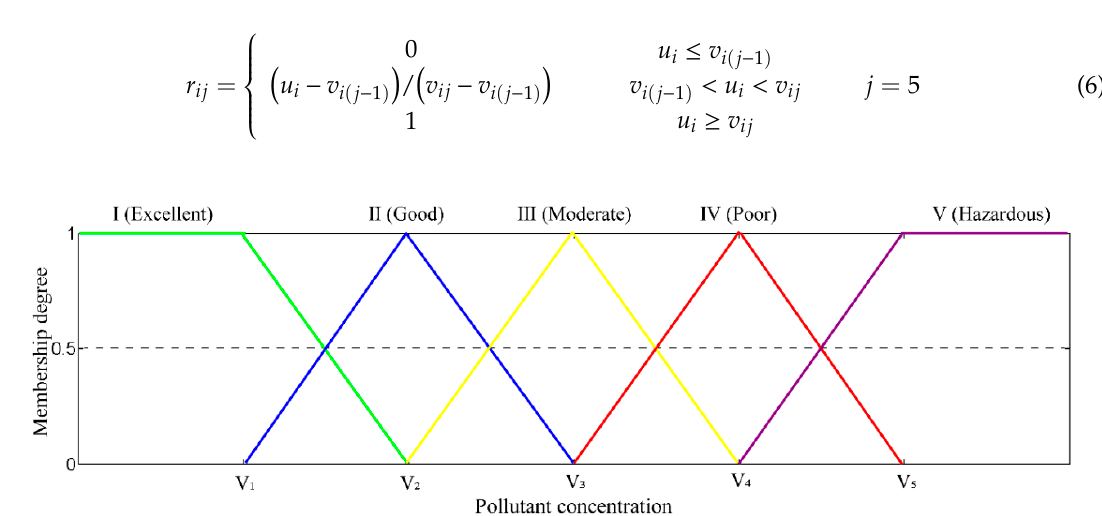
Figure 1. Membership function of air pollutant concentration.